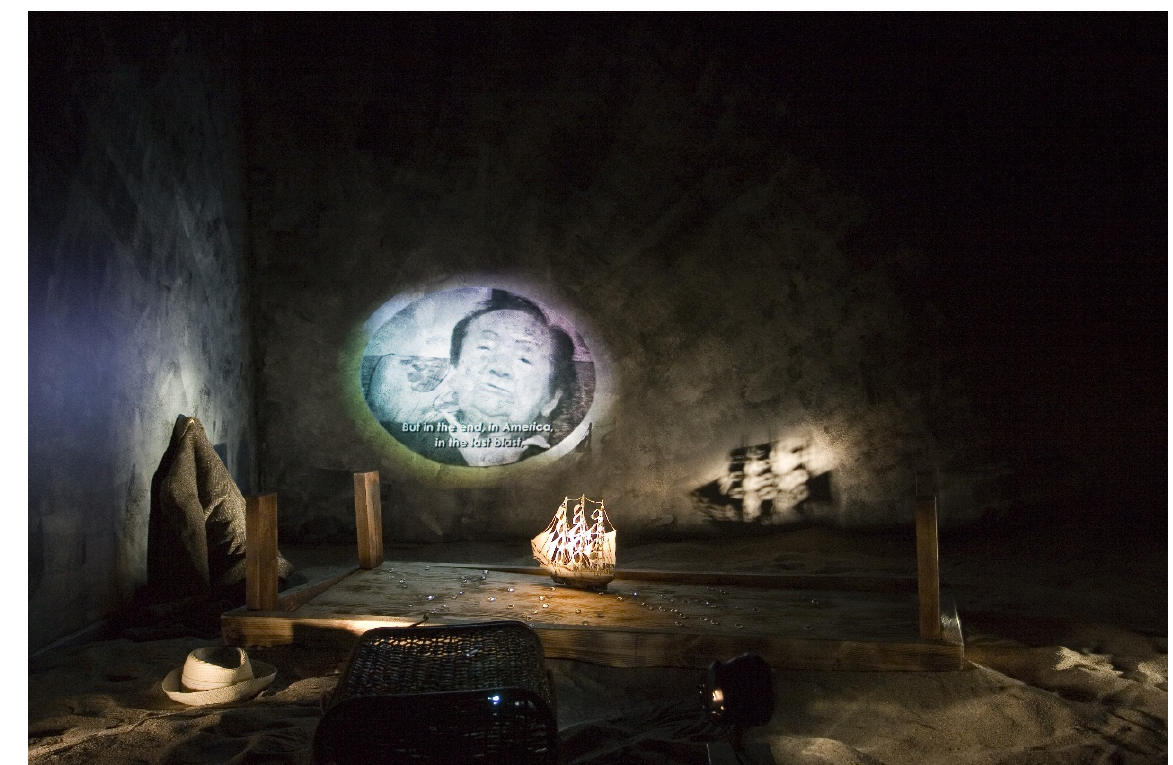
Figure 8. Miri Nishri. “Troubled Water”, 2006. Installation. (C) Courtesy of the artist.